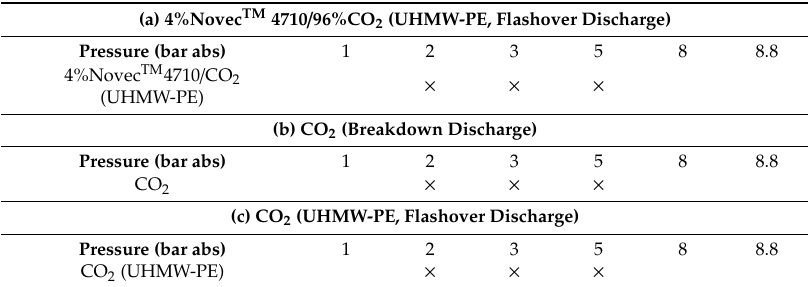
Table 5. Glow Corona onset as a function of pressure